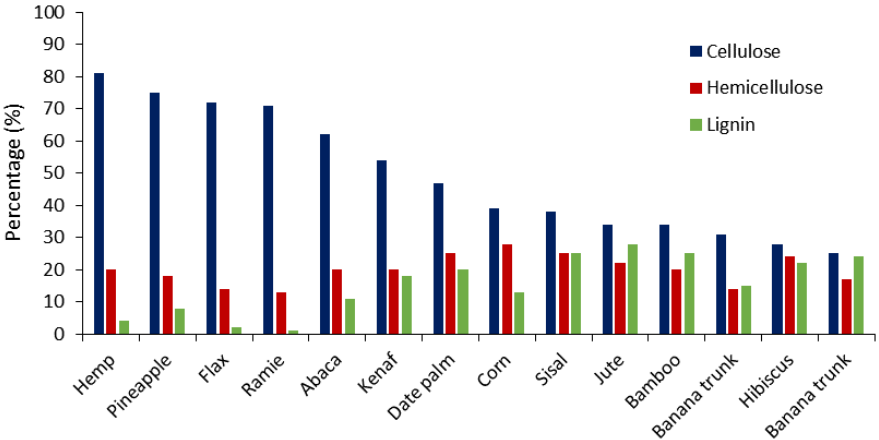
Figure 2. Cellulose, hemicellulose, and lignin content in date palm against other plants [18–20].